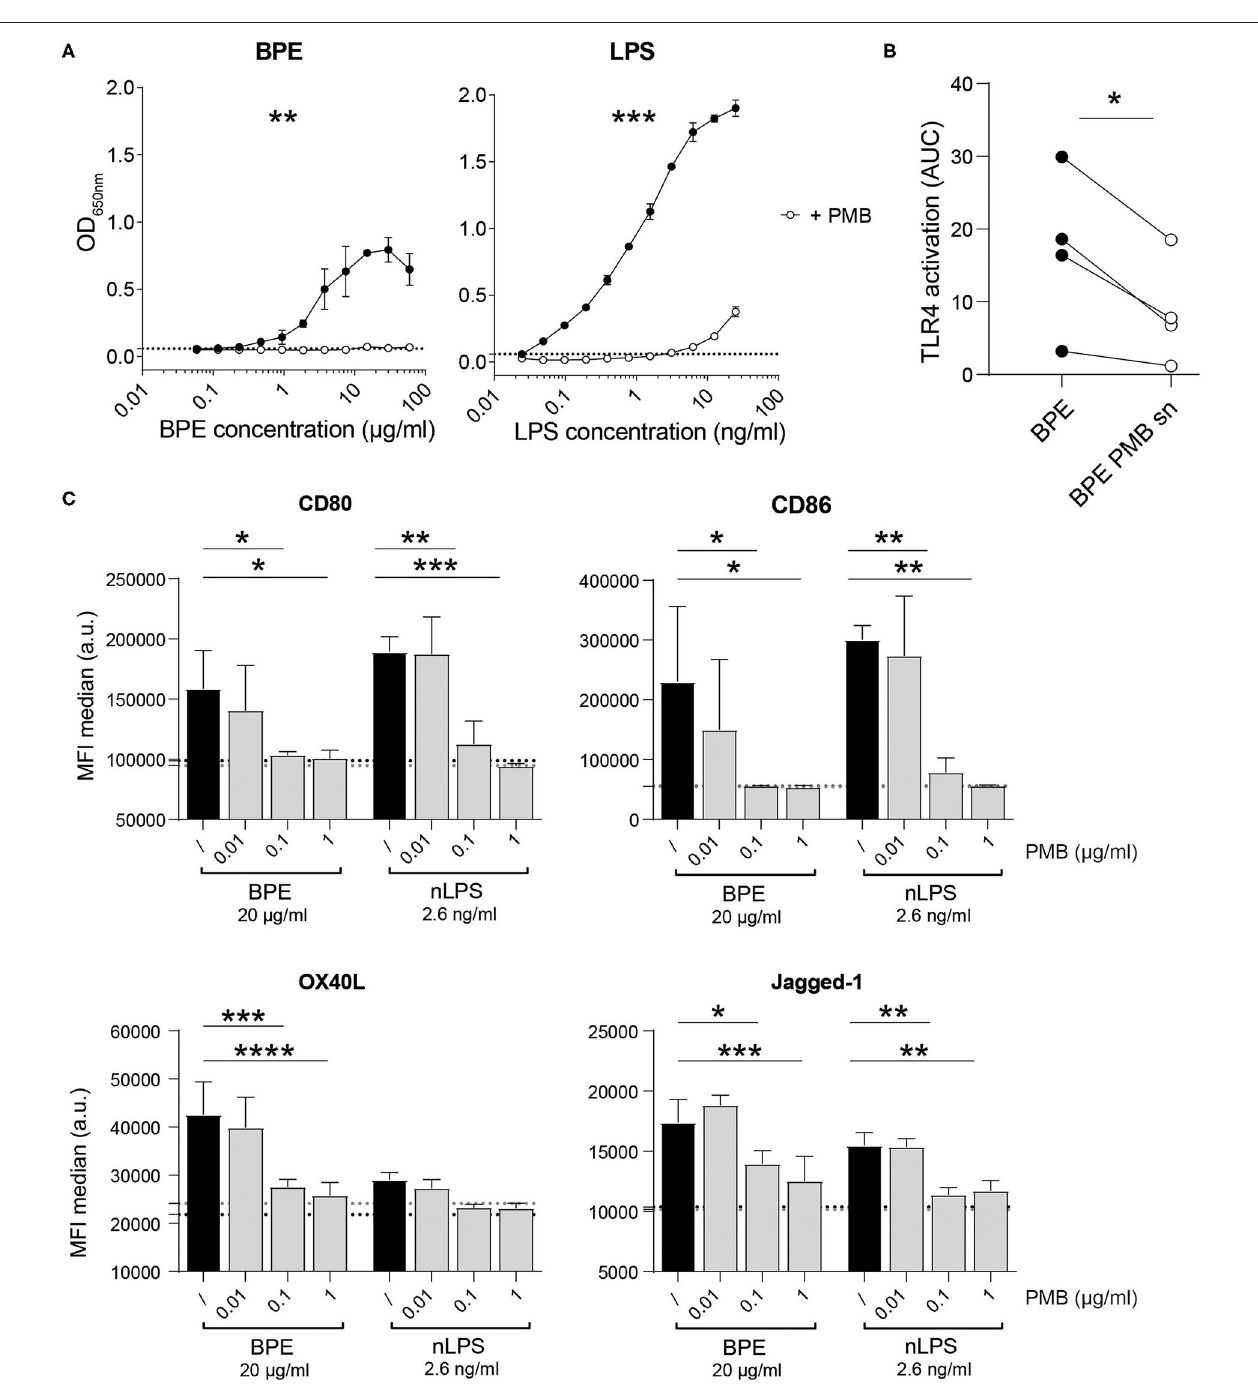
FIGURE 2 | BPE- and nLPS-induced TLR4-NF κ B signaling and murine BMDC activation are inhibited by PMB. Murine TLR4 HEK-blue reporter cells were treated with 5 µ g/ml PMB 30min prior to stimulation with serial dilutions of LPS and BPE (A) . Comparison of the TLR4 signaling activity induced by BPE before and after (BPE PMB sn) the PMB-pull down assay (B) . Data represent the area under the curve (AUC) of the results of four individual mTLR4 HEK assays. The expression of the surface markers CD80, CD40, OX40L, and Jagged-1 was analyzed on C57/BL6 BMDCs pretreated for 1h with 0.01, 0.1, or 1 µ g/ml of soluble PMB (gray bars) or untreated (/, black bars) before stimulation with 20 µ g/ml BPE or 2.6ng/ml nLPS. Black and gray dotted lines represent the average of medium- or PMB-treated cells (highest PMB concentration, 1 µ g/ml), respectively. The BMDC activation assays were performed in triplicates. Results are representative of three individually performed experiments (C) . Statistics were calculated using either an un-paired Student’s t -test on the area under the curve (AUC) obtained from duplicate measurements (A) , a paired Student’s t -test (B) , or a Two-Way ANOVA with a Dunnett’s multiple comparisons test (C) .